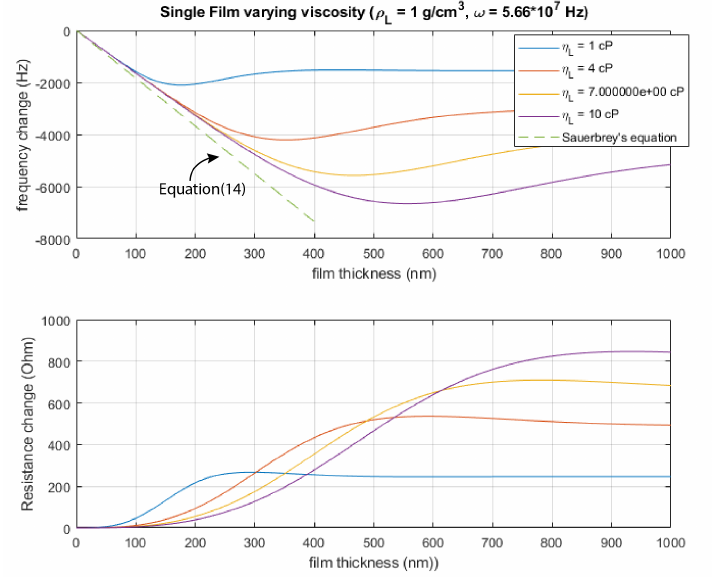
Figure 15. QCM response simulation using Mason equivalent circuit varying viscosity.